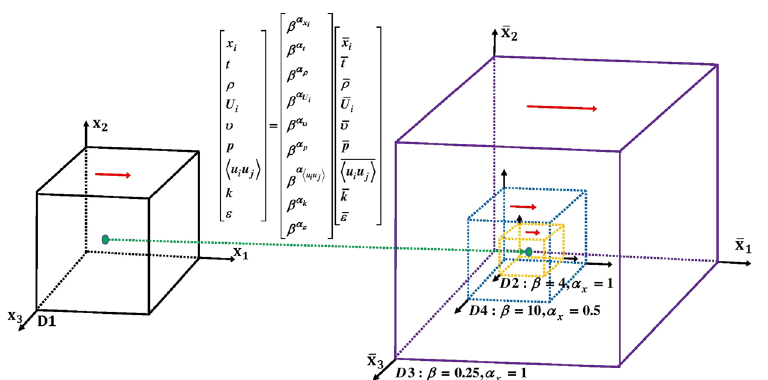
Figure 1. Schematic descriptions of the simulated self-similar cubic cavity flows (not to scale): original domain (D1) and its self-similar domains (D2, D3, and D4). Flow variables at specified time and space can be mapped to those at the corresponding time and space in the self-similar domains by means of Lie Group of scaling transformations. It is possible to obtain both larger and smaller domains by the selection of the scaling parameter β and the scaling exponent of length α x .